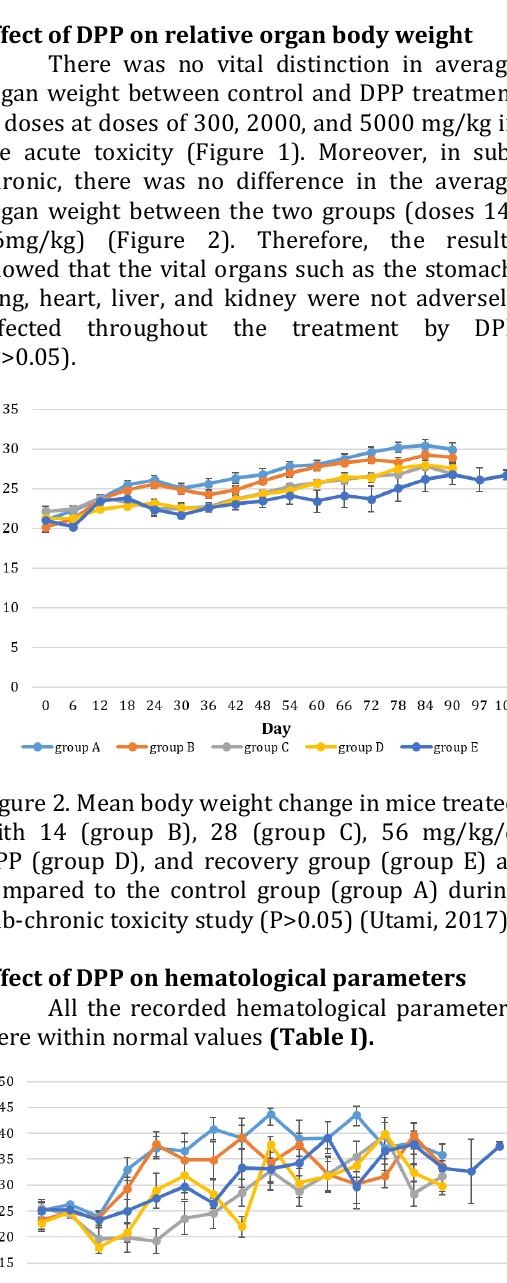
Figure 3. Mean food consumption in mice treated with 14 (group B), 28 (group C), 56 mg/kg/d DPP (group D), and recovery group (group E) as compared to the control group (group A) during sub-chronic toxicity study (P>0.05) (Utami,